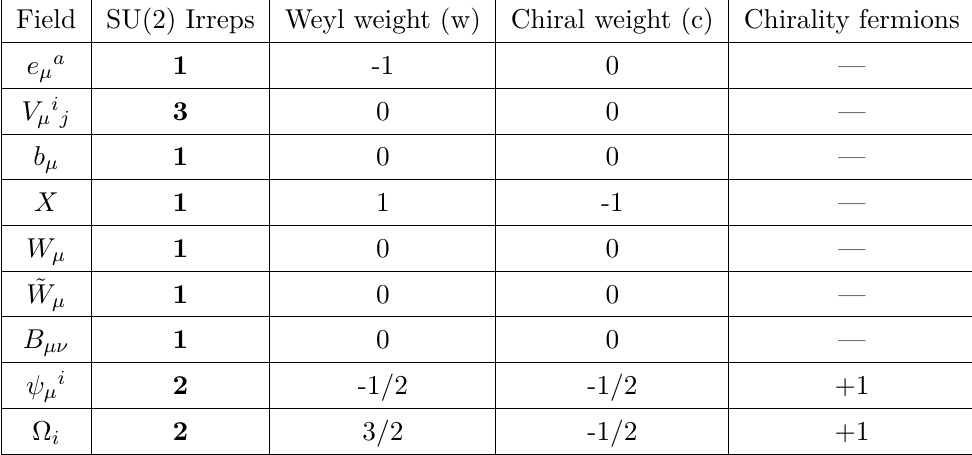
Table 1 . N = 2 superconformal dilaton Weyl